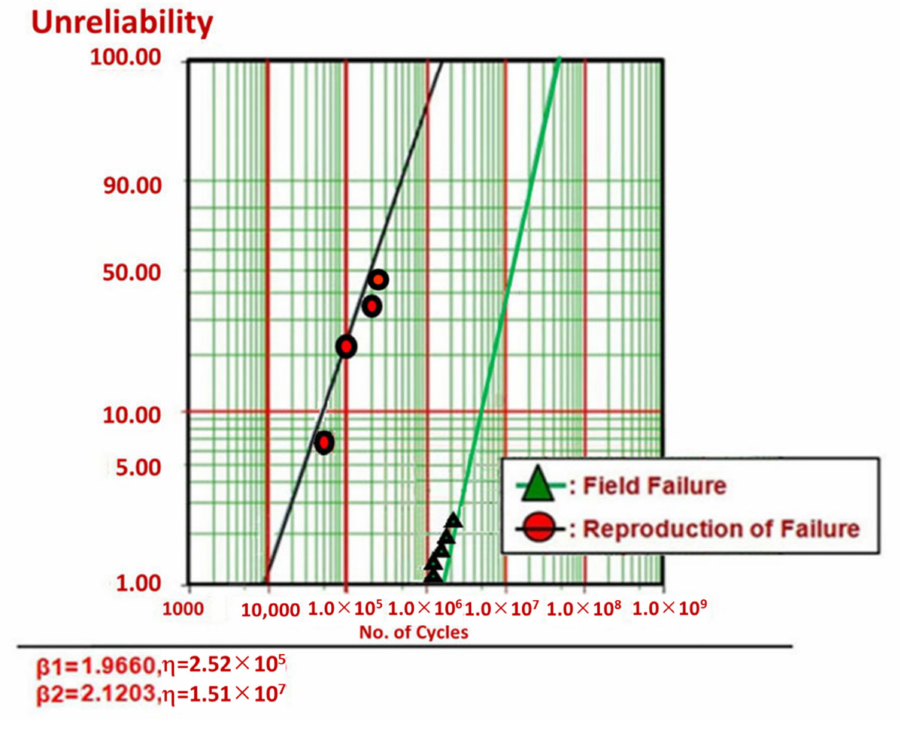
Figure 13. Market statistics and consequences of ALT on Weibull chart.